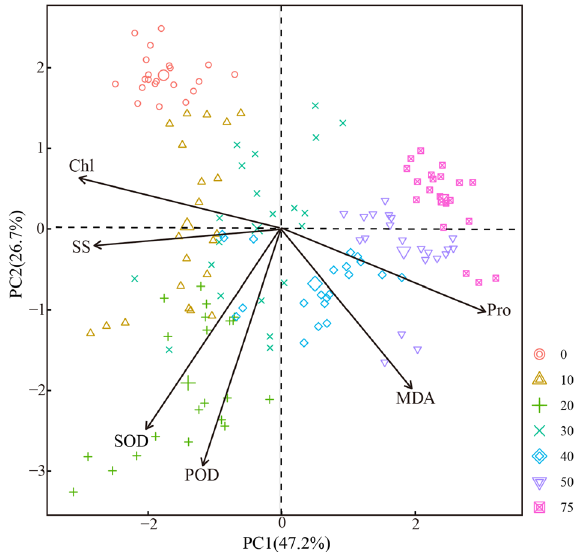
Figure 4. Principal component analysis of physiological properties. The introduction of Chl, MDA, POD, Pro, SOD and SS have showed in Fig.